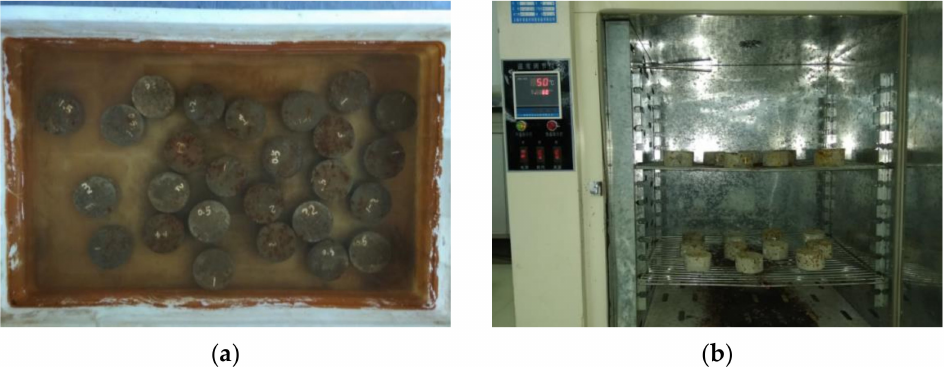
Figure 2. Drying–wetting accelerated corrosion samples. ( a ) Samples were immersed in NaCl solution, ( b ) samples were dried in an